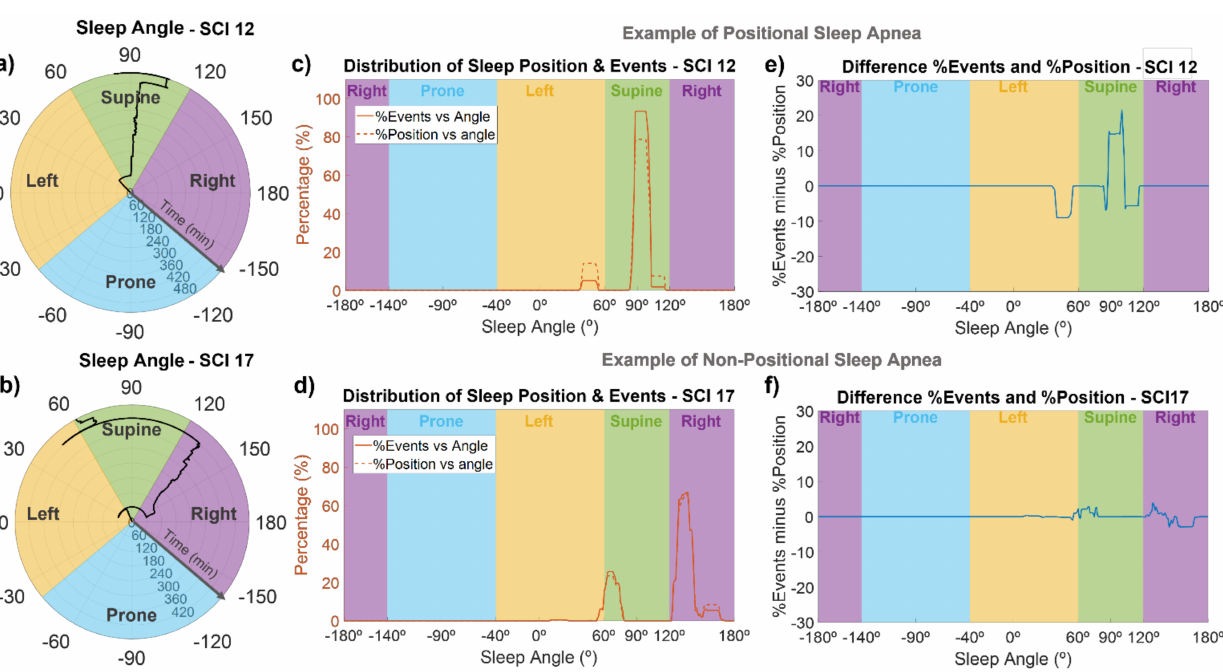
Figure 4. Sleep angle and association between the sleep position and apnea/hypopnea events for two representative SCI patients. The first column ( a , b ) are polar plots indicating the sleep angle as a function of time, the middle column ( c , d ) shows the percentage of time spent at each sleep angle (dashed line), and the percentage of events occurring during each angle (solid line), and the last column ( e , f ) shows the difference between the percentage of time and percentage of events at each sleep angle. SCI 12 (upper panels) is an example of a patient with positional sleep apnea, with an increased frequency of events in supine position, while SCI 17 (lower panels) is an example of a patient with non-positional sleep